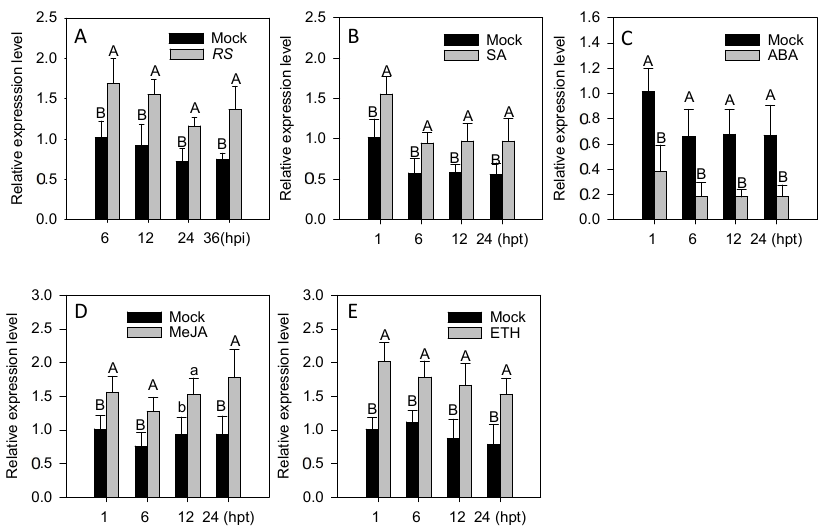
Figure 2. QRT-PCR analysis of relative CaWRKY22 transcriptional levels in pepper plant leaves exposed to Ralstonia Solanacearum inoculation (RSI) and different phytohormones. QRT-PCR was performed to detect the expression levels of CaWRKY22 in pepper leaves under several treatments including R. Solanacearum inoculation, ( A ) application of 1 mM SA; ( B ) application of 100 µm ABA; ( C ) application of 100 µm MeJA; ( D ) and application of 100 µm ETH; ( E ) at different time-points. ( A ) The transcriptional levels in RSI-treated pepper leaves were compared with those in MgCl 2 -treated control plants (mock), whose relative expression level was set to “1”. ( B – E ) The transcriptional levels in hormone-treated pepper leaves were compared with those in ddH 2 O-treated plants (mock), whose expression level was set to “1”. Error bars indicated the standard error. Different letters above the bar show a significant difference between the means of the three biological replicates based on the Fisher’s protected LSD test: uppercase letters, p < 0.01; lower case letters, p <